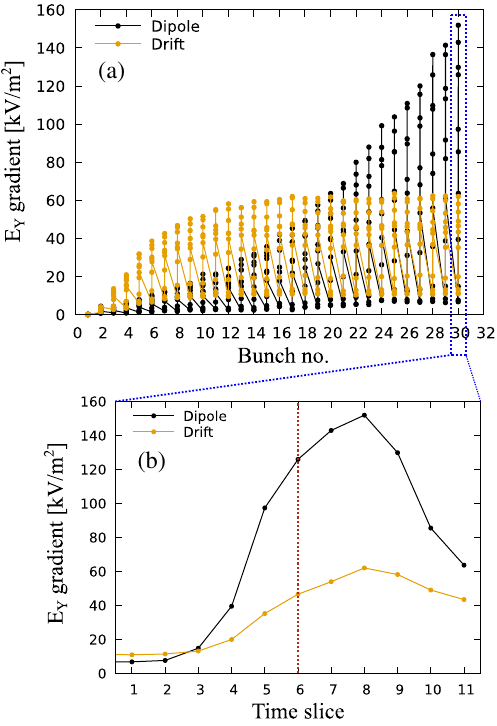
FIG. 25. (a) Vertical electron cloud space-charge electric field gradients for the 11 time slices within each of 30 bunches for dipoles and field-free regions. (b) Electric field gradients for the 11 time slices in bunch 30, showing the center of the bunch at time slice 6. (Beam energy is 2.1